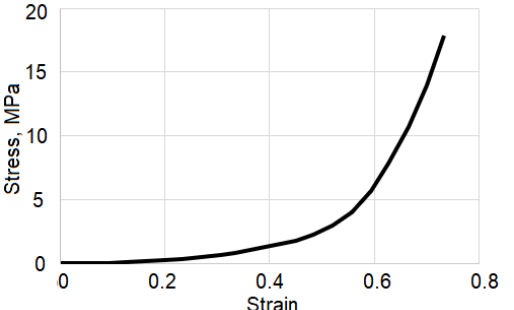
Figure 4. Stress–strain curve representing the mechanical properties of meniscus.